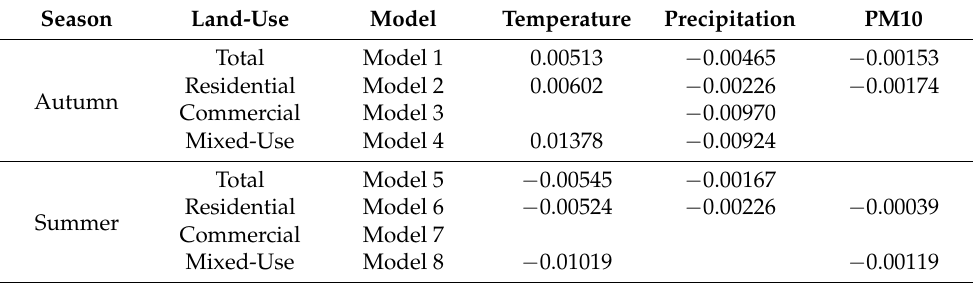
Table 11. Summary of the microclimatic variable regression